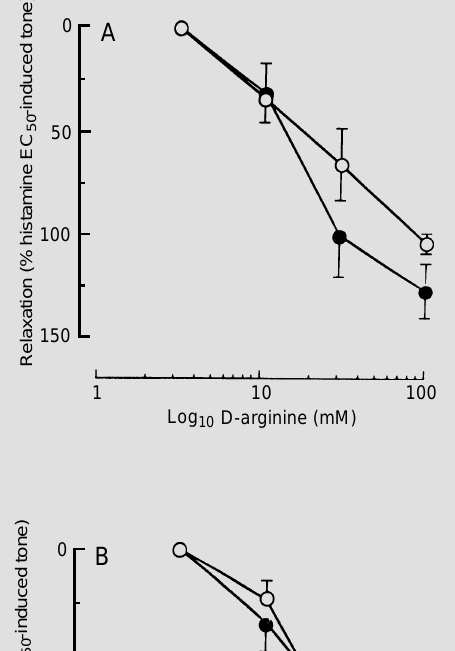
Figure 5 - Relaxant response curves for D-arginine in the ab- sence (A) and presence (B) of L- NAME (50 µM) in epithelium-in- tact (open circles) and epithe- lium-denuded (closed circles) guinea-pig isolated trachea pre- contracted with histamine (EC 50 ). Each point represents the mean of 5-6 observations and vertical bars represent the SEM. Indomethacin (5 µM) is present